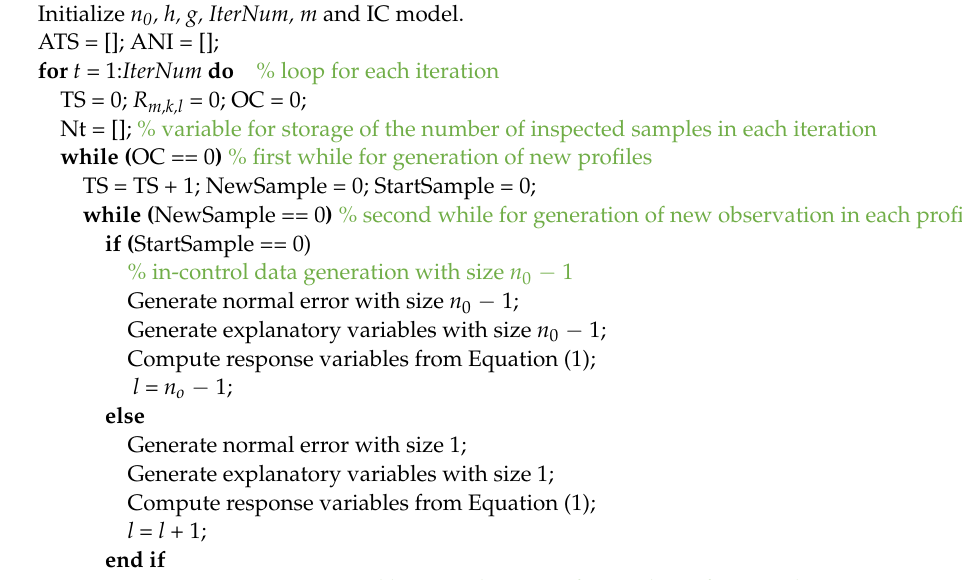
Pseudocode 3. The procedure of ATS 0 and SDTS 0 computations in